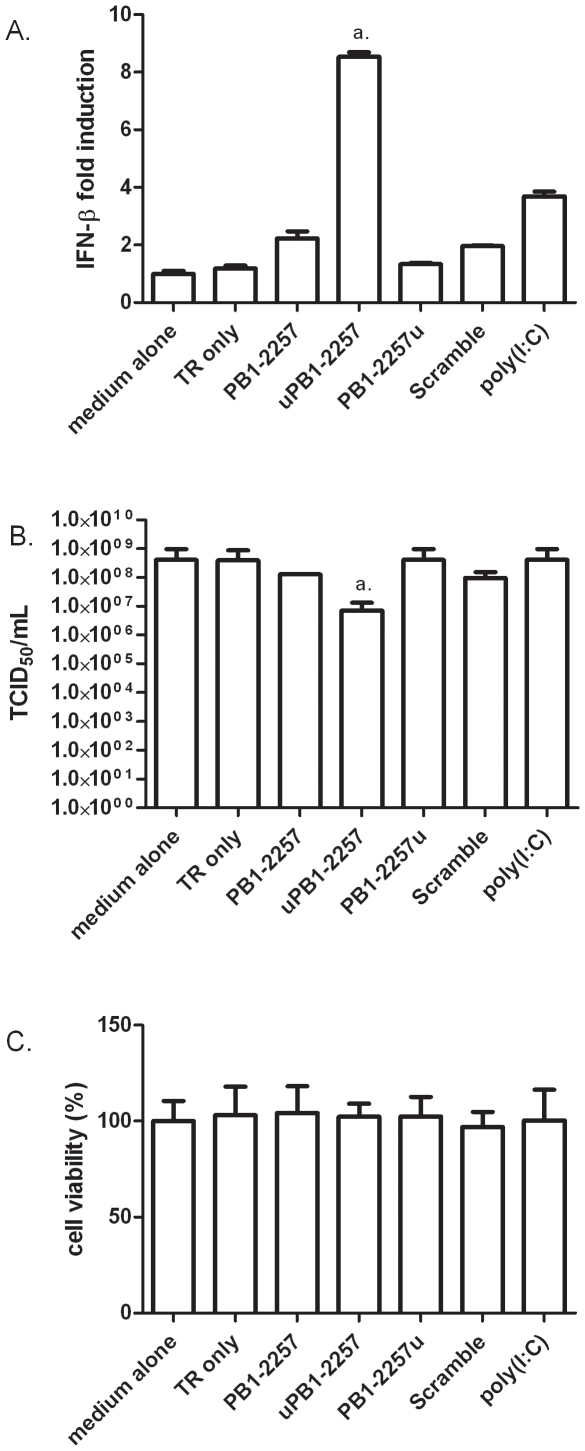
Inhibition of H5N1 influenza virus growth by
5′-UGUGU-3′
-tagged PB1-2257.(A) IFN-β mRNA levels in HD-11 cells transfected with c-siRNAs (all 20 pmol). Data shows IFN-β mRNA levels 8 h post-transfection. a. = p<0.01 between levels of IFN-β in cells transfected with uPB1-2257 versus PB1-2257. (B) TCID50 of H5N1 virus growth in HD-11 cells transfected with c-siRNAs (5 pmol, 96 well plate) or polyI:C (0.1 µg). Cells were transfected with siRNAs and infected with H5N1 virus 24 h later at dilutions of virus of 10-1to 10−7. Cells were rinsed with fresh medium before the addition of virus. TCID50 values were measured 72 h post-infection. Each value is the mean + standard deviation (4 replicates). a = p<0.05 between virus levels in cell supernatants of cells treated with PB1-2257 or uPB1-2257. (C) Viability of HD-11 cells 24 h post-transfection with c-siRNAs (5 pmol, 96 well plate) as measured by Alamar blue. Results are representative of 3 separate experiments.